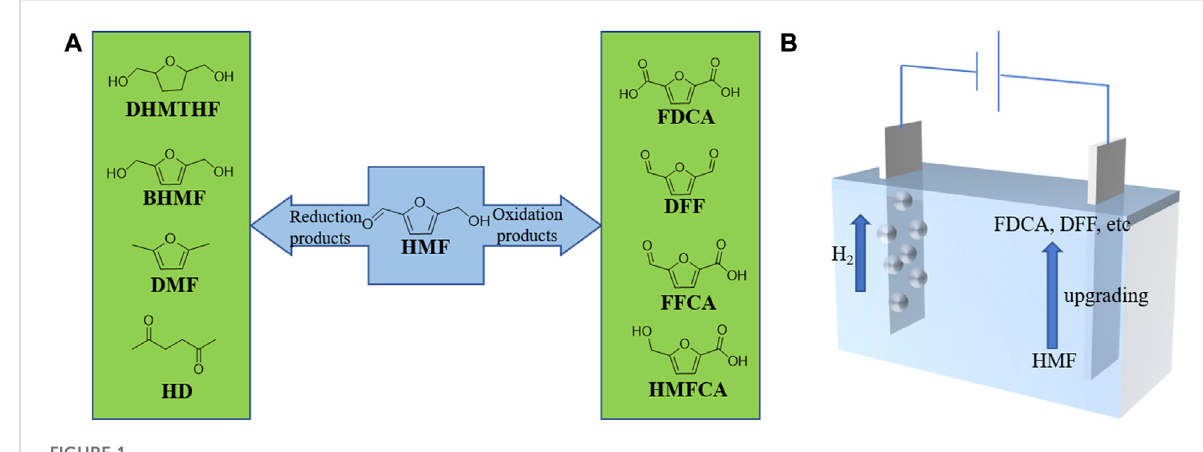
FIGURE 1 (A) Reductive and oxidative products of HMF upgrading. (B) Paired electrolysis of HMF oxidation with